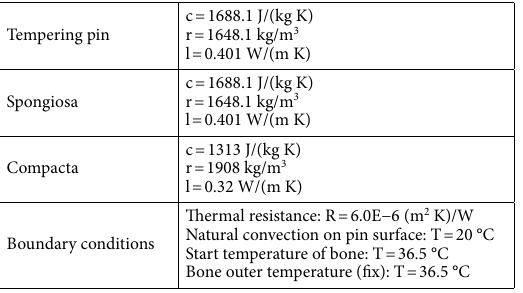
Table 1. Table with thermophysical material properties and simulation boundary conditions.